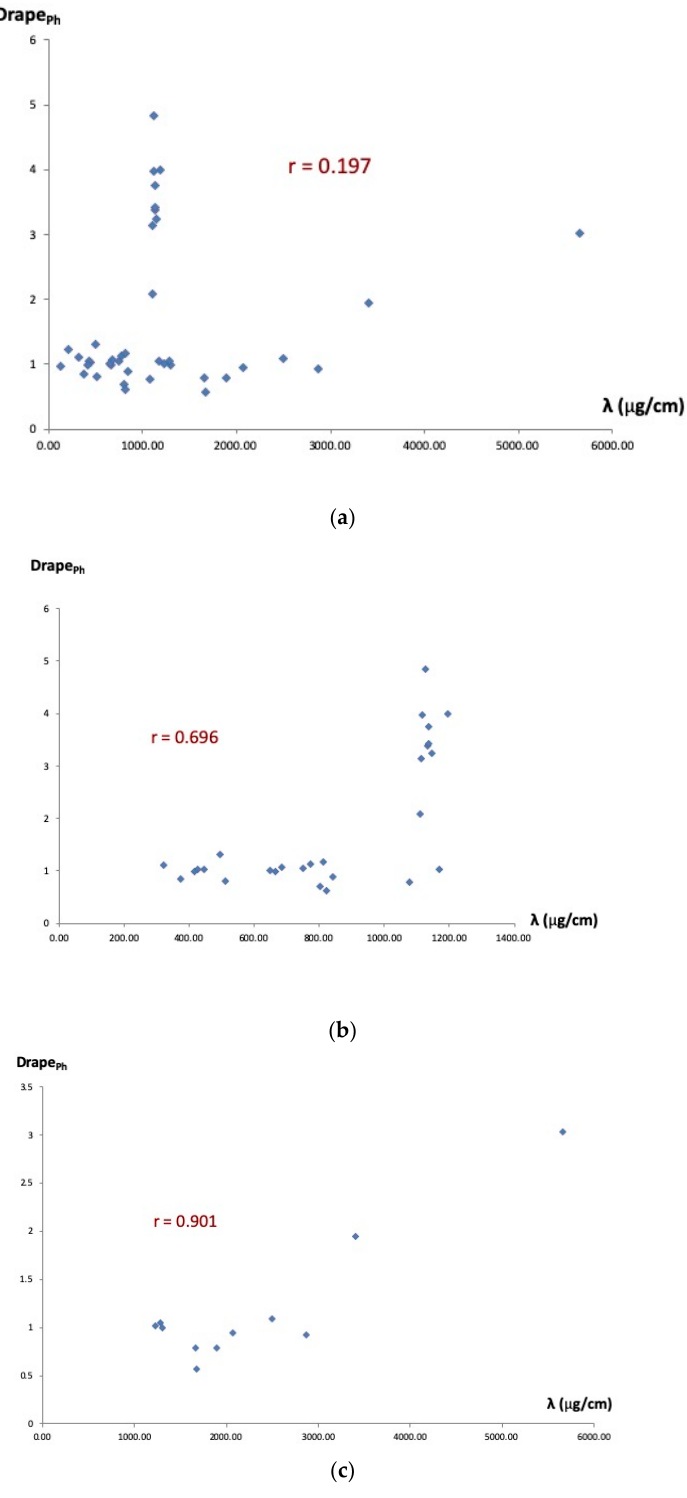
Figure 9. ( a ) PhabrOmeter Drape and UCD Linear Density (n = 40); ( b ) PhabrOmeter Drape data and Linear Density (Light weight only n = 27); and ( c ) PhabrOmeter Drape and Linear Density (Medium weight only, n = 11).